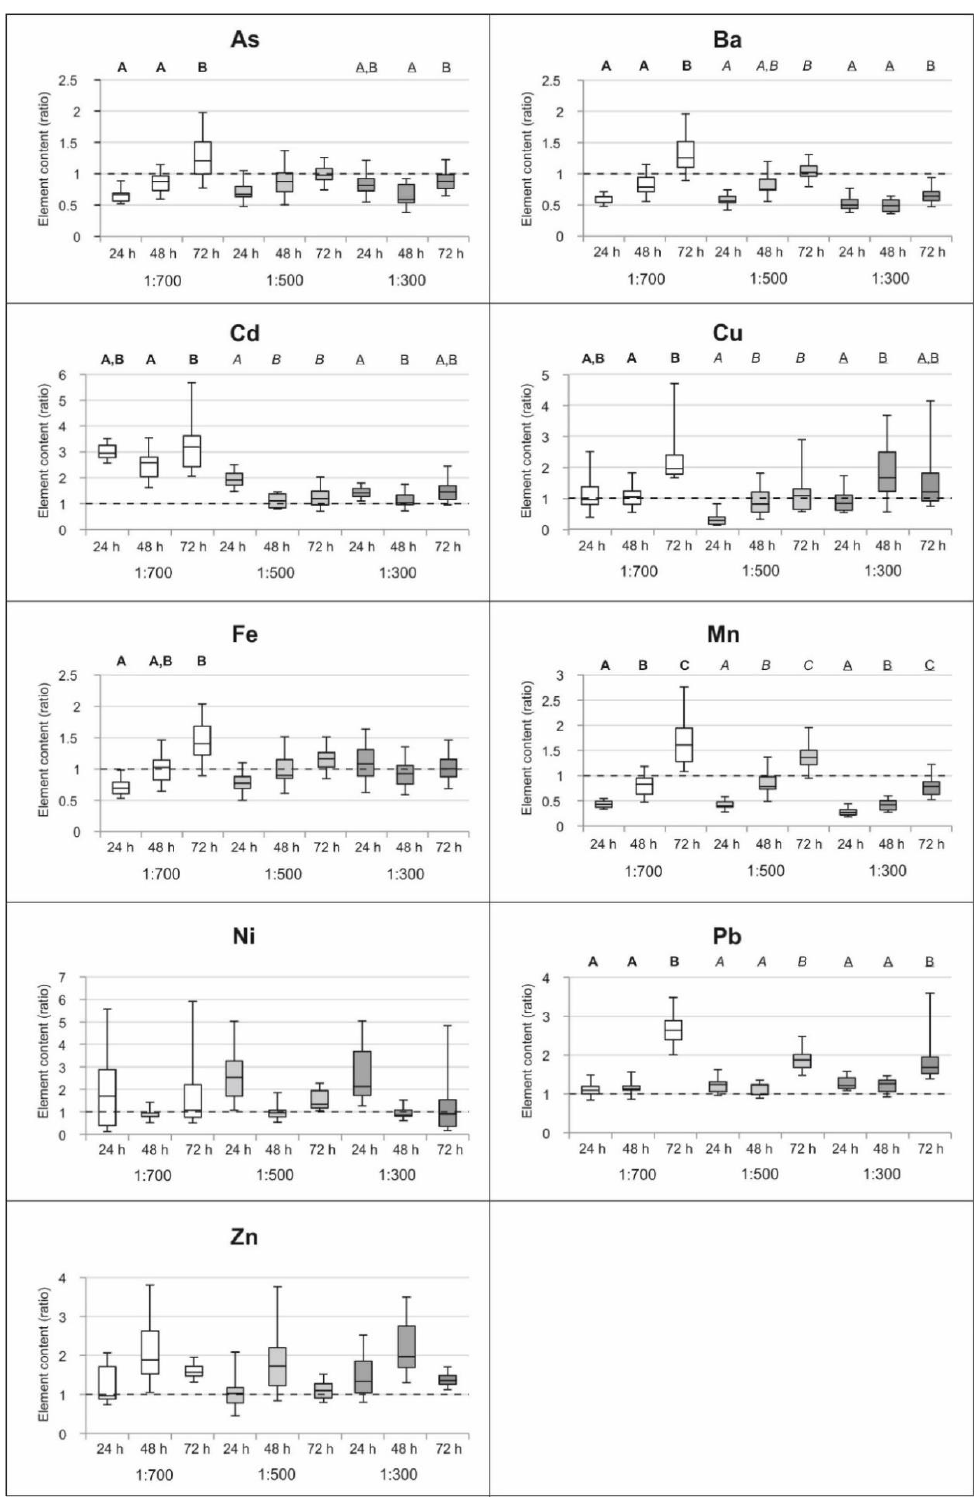
Figure 1. Expression of trace elements content in Azolla filiculoides (in terms of median, quartiles, min and max of ratios–normalized values to the control) treated with wood distillate solutions at 1:700, 1:500, 1:300 after three incubation periods (24 h, 48 h, 72 h) ( N = 3). Statistically significant ( p < 0.05) differences between the treatments along time are indicated by different capital letters (bold for 1:700, italic for 1:500, underlined for 1:300).